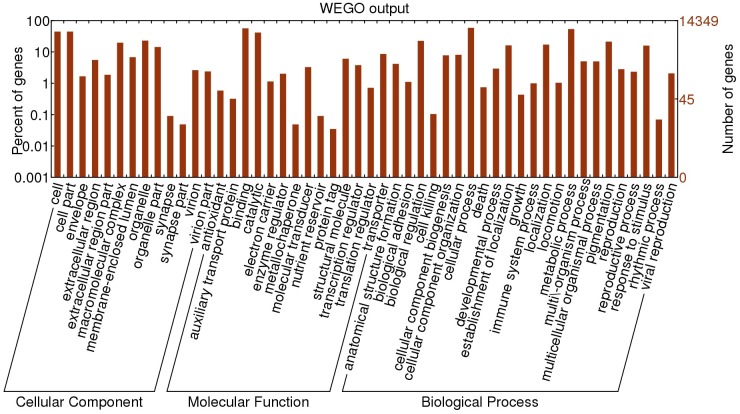
GO Classification of C. Ciliata unigenes according to the categories of Biological process, Molecular function and Cellular component.